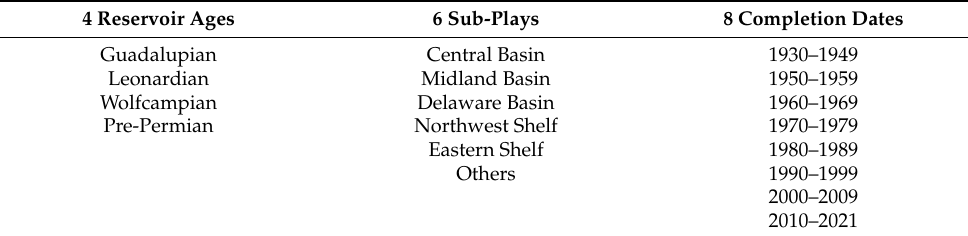
Table 2. Design of 192 well cohorts = 4 reservoir ages × 6 sub-plays × 8 completion dates.